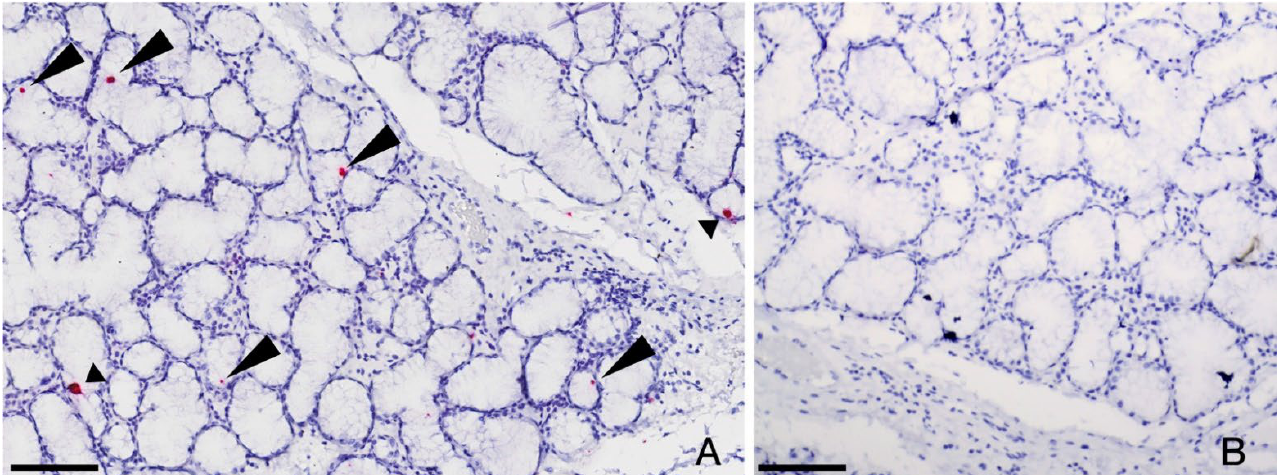
Figure 1. In situ hybridization to detect FcaGHV1 DNA in feline salivary gland. ( A ) FcaGHV-1 probe hybridization is detected within the nuclei of scattered glandular epithelial cells of the salivary gland (arrowheads). ( B ) Using an unrelated probe (DapB), no hybridization is detectable in a duplicate slide (cut in series). Bars 100 µ